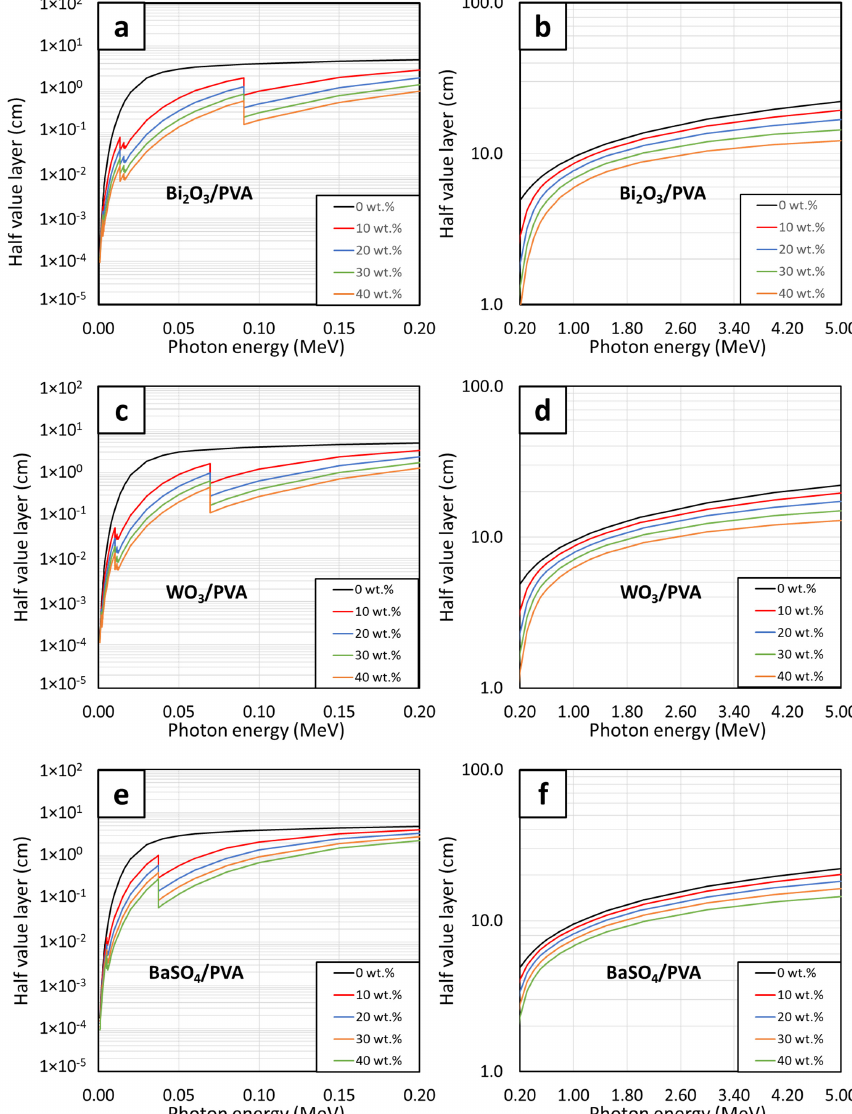
Figure 6. HVL values of ( a , b ) Bi 2 O 3 /PVA, ( c , d ) WO 3 /PVA, and ( e , f ) BaSO 4 /PVA hydrogels containing varying filler contents of 0, 10, 20, 30, and 40 wt.%, determined at photon energies of ( a , c , e ) 0.001–0.2 MeV and ( b , d , f ) 0.2–5 MeV using